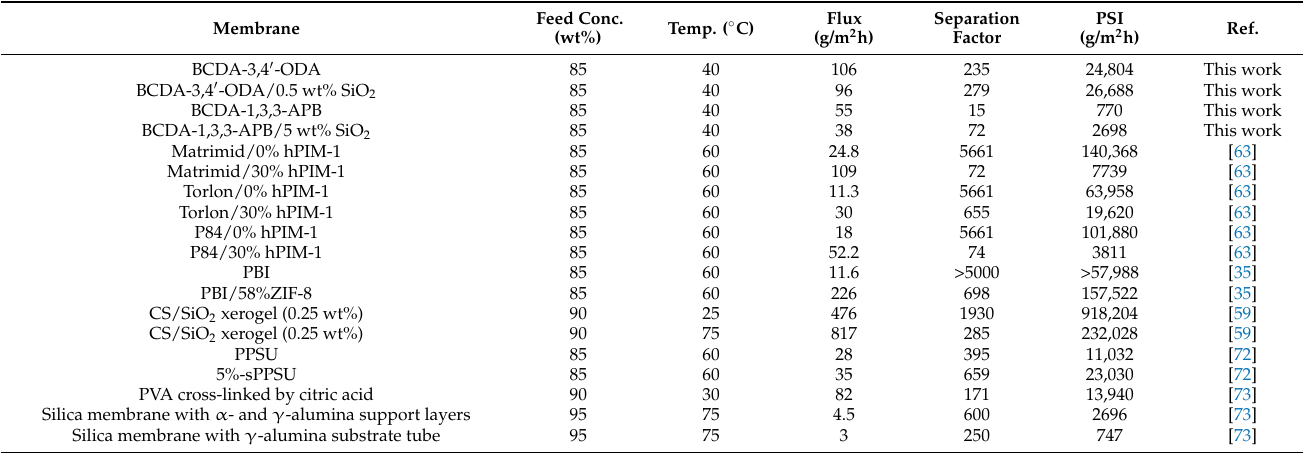
Table 5. Comparison of water/n-butanol pervaporation performance of alicyclic PI/SiO 2 mixed matrix membranes with